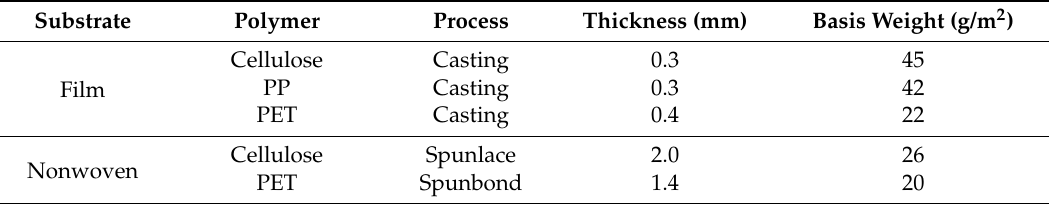
Table 1. Film and nonwoven substrates